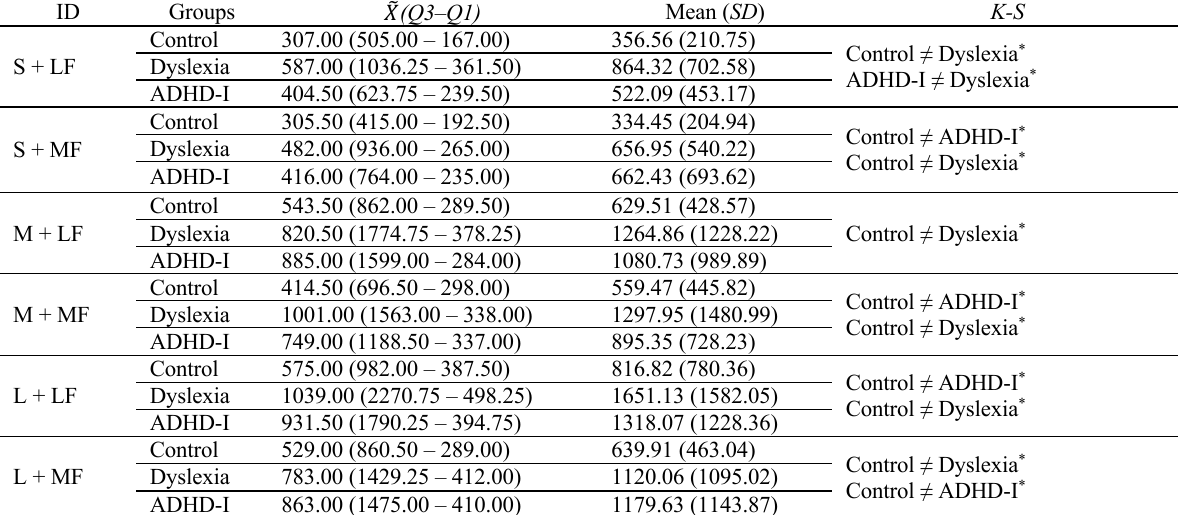
Table 8 – Median, 1 st and 3 rd percentiles, mean, standard deviation, and multiple comparison test: Second Pass Reading Time (in milliseconds) as a Function of Word Frequency and Word Length interaction in Dyslexia, Control and ADHD-I